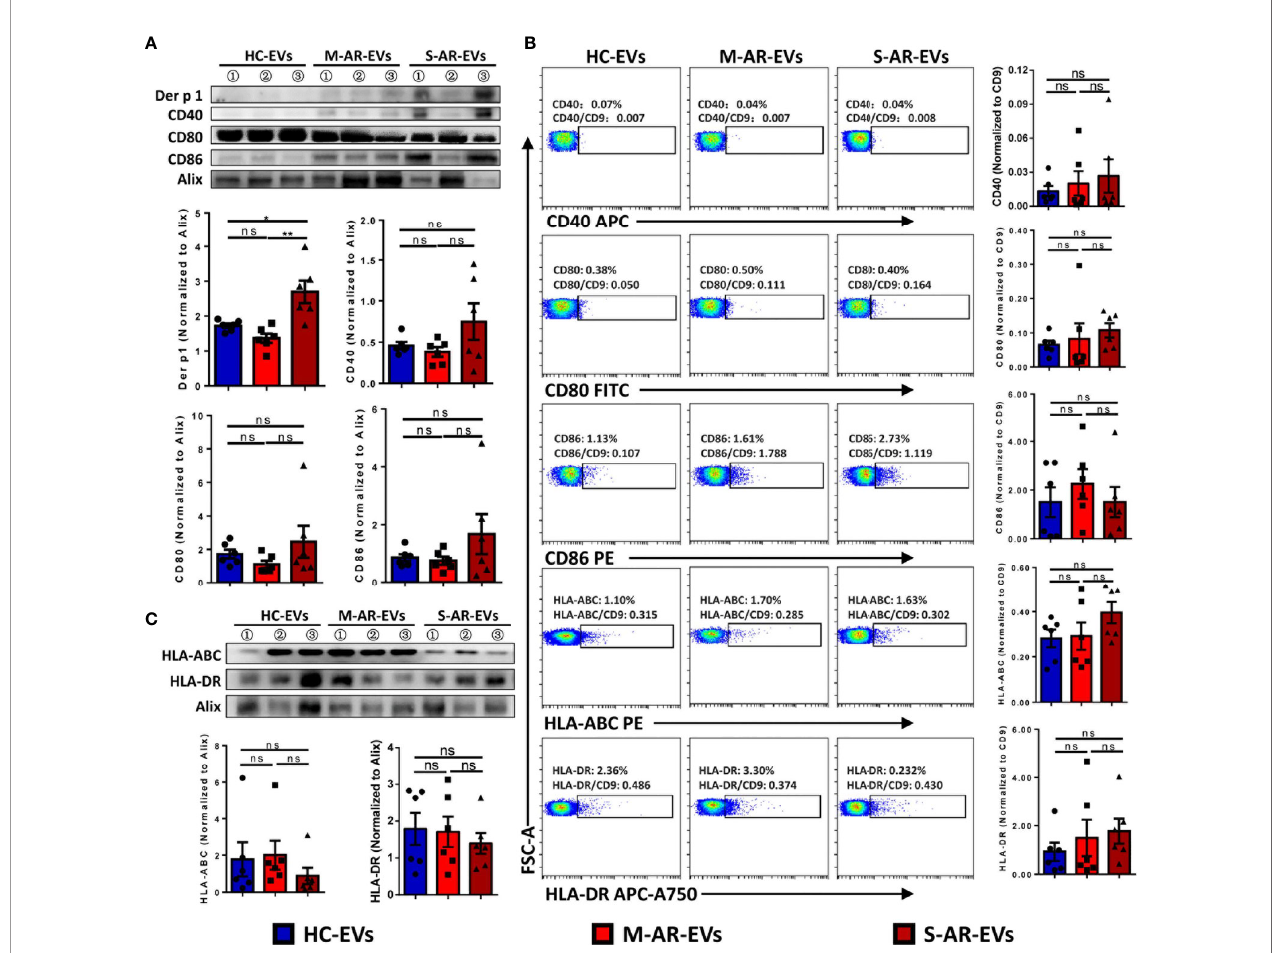
FIGURE 3 | Determination of Der p 1, costimulatory molecules, and antigen presentation molecules on plasma EVs. The expression of costimulatory molecules (A) and antigen presentation molecules (B) was similar among plasma EVs derived from HC subjects and patients with M-AR and S-AR, while the expression of Der p 1 was signi fi cantly higher in patients with S-AR, as determined by Western blot. (C) No signi fi cant difference was found on levels of costimulatory and antigen presentation molecules on plasma EVs derived from HC subjects and patients with M-AR and S-AR, as suggested by fl ow cytometry analysis. EVs, Extracellular vesicles; HC, Healthy control; M-AR, Mild allergic rhinitis; ns, no signi fi cance; S-AR, Moderate-severe allergic rhinitis. Data are shown as mean ± SEM. Western blot of Der p 1, CD40, CD80, and CD86, as well as fl ow cytometry analysis of CD86 and HLA-ABC, were analyzed by Mann – Whitney U test; the other data were analyzed by one-way ANOVA multiple comparison. * p < 0.05. The data were combined from two independent